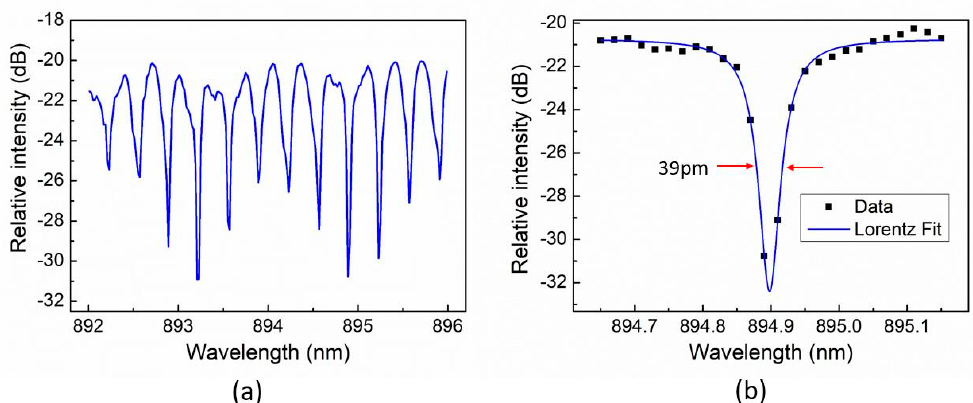
Figure 9. (a) Optical transmission spectrum of the fabricated microring resonator under TE mode; (b) Lorentzian fit of the single resonance peak.